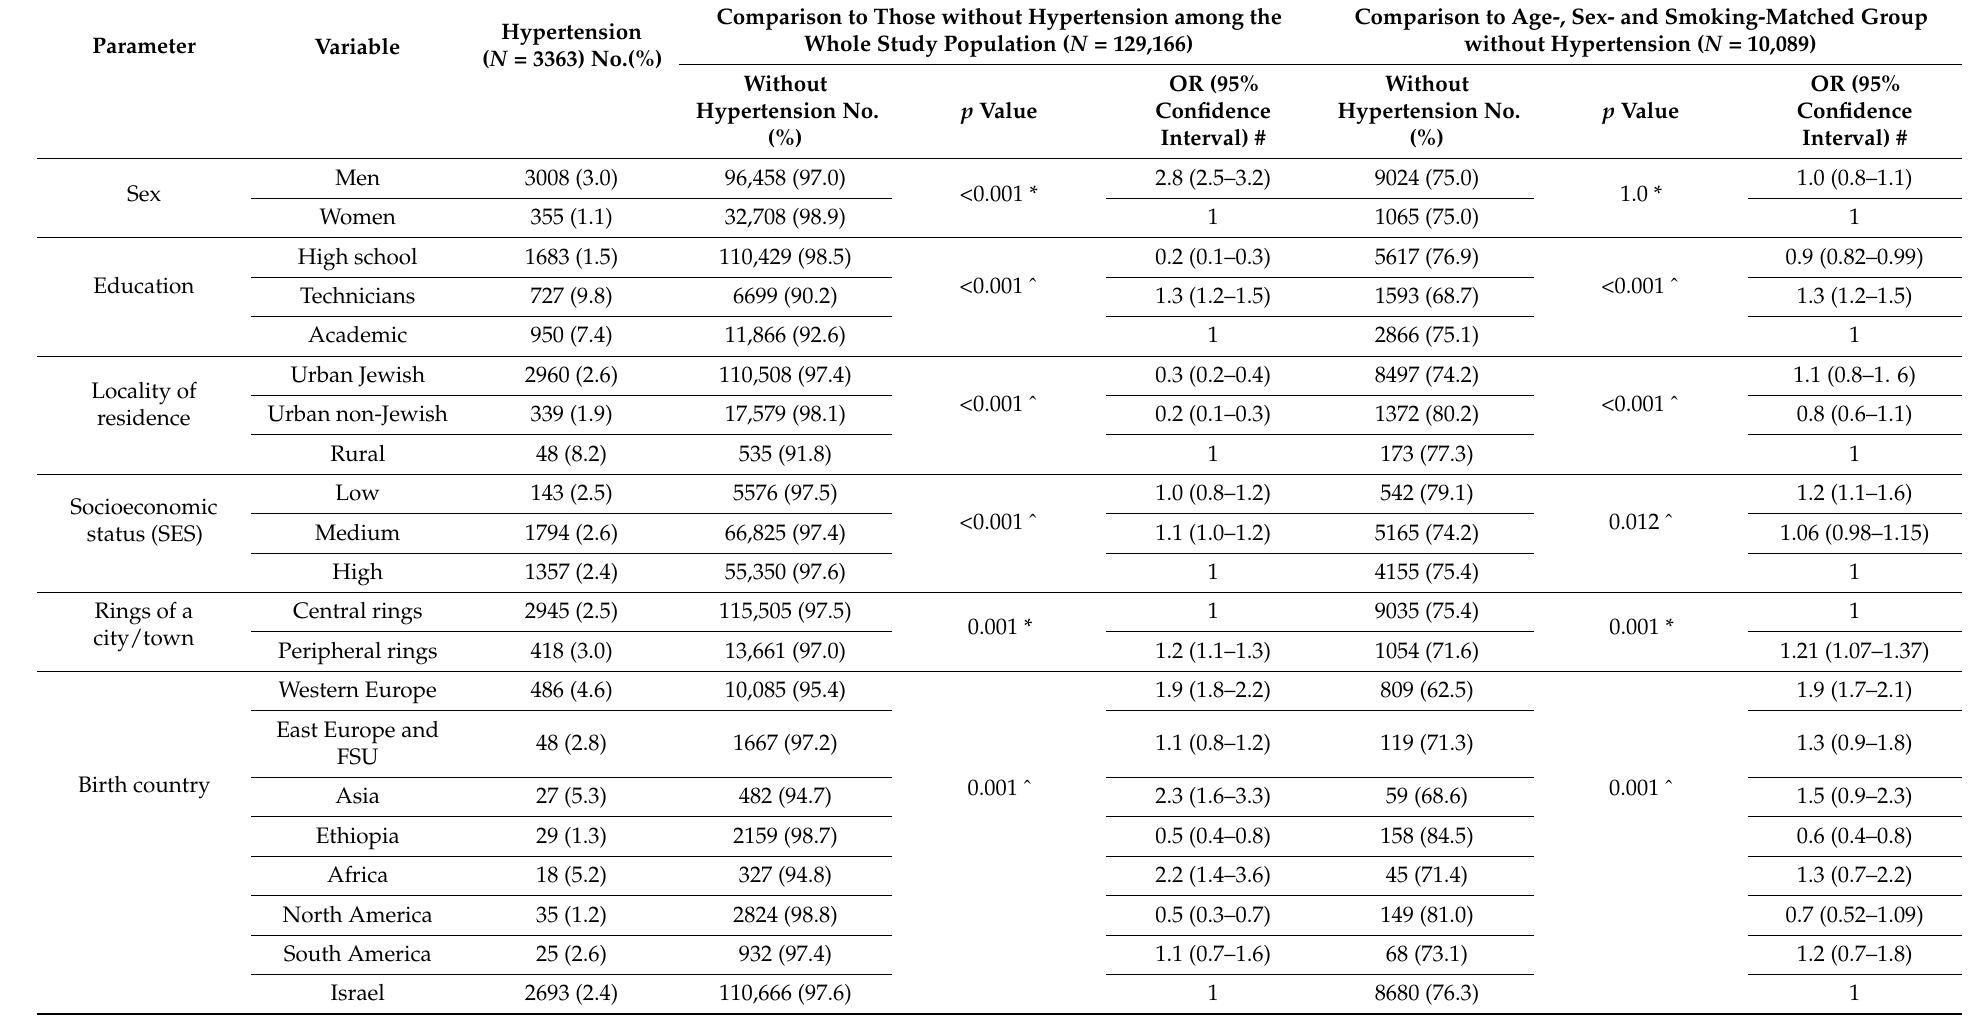
Table 1. The associations between socio-demographic parameters and hypertension diagnosis among the study population and among the age-, sex- and smoking-matched sub-population.